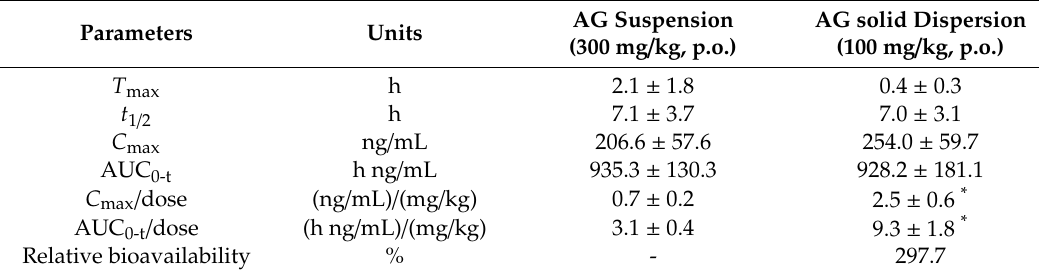
Table 2. Pharmacokinetic parameters of andrographolide (AG) after oral administration of AG suspension, and AG-loaded solid dispersion in